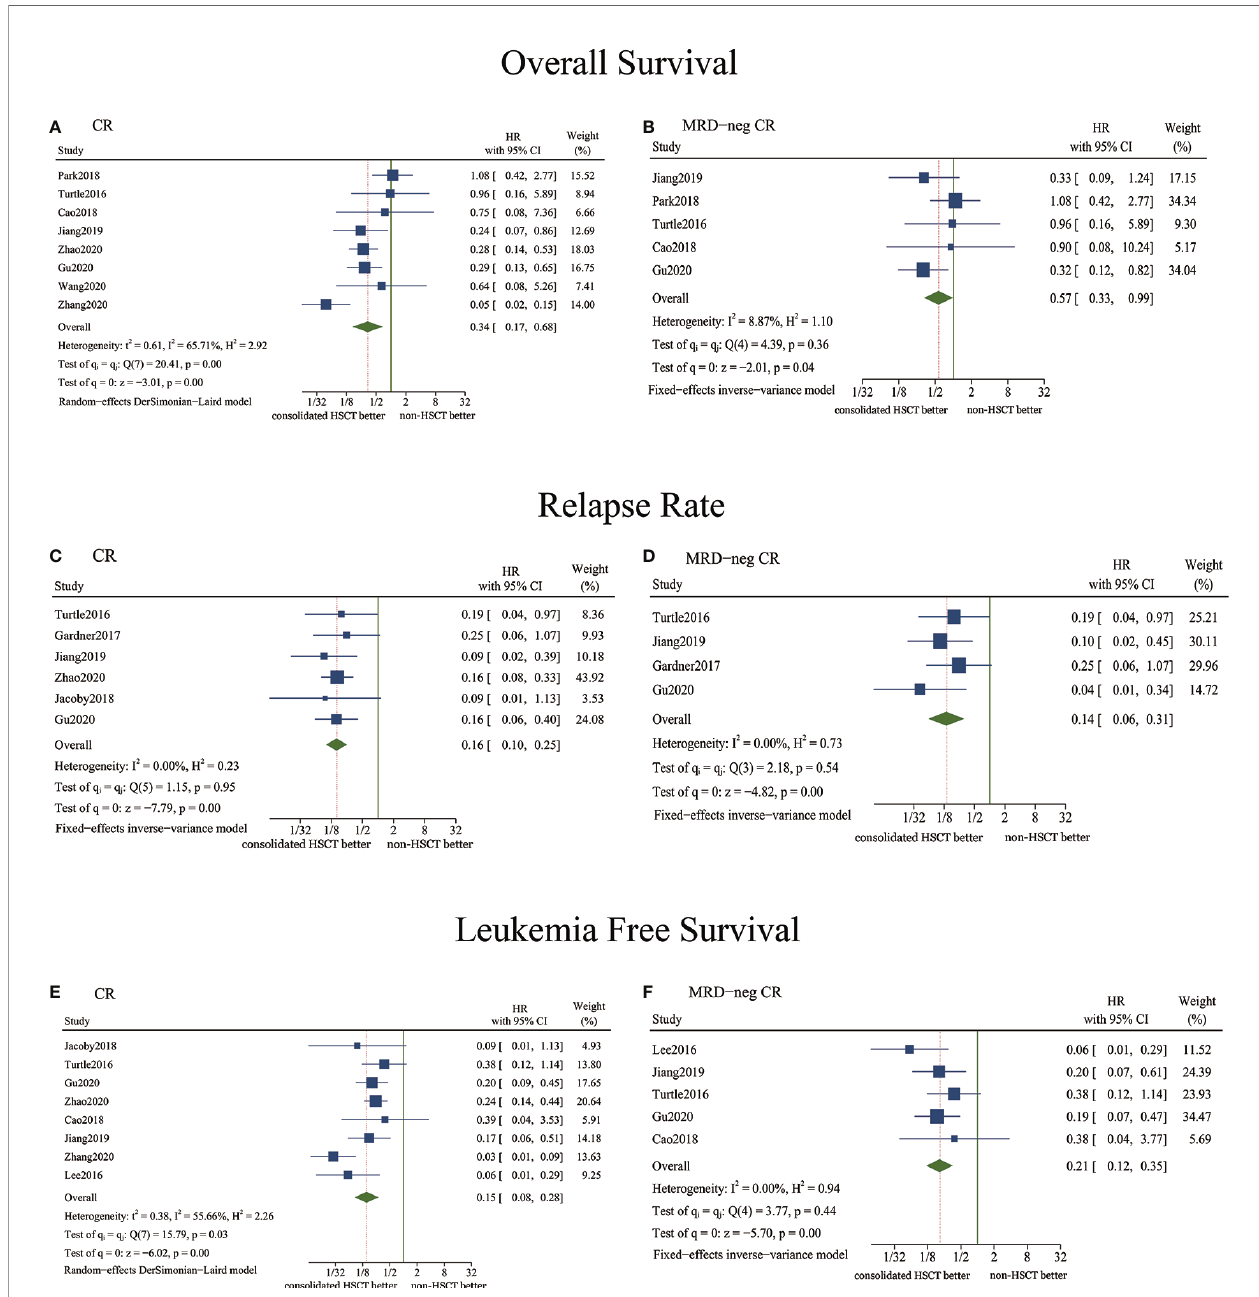
FIGURE 2 | Forest plots of ef fi cacy outcomes comparing consolidative HSCT and non-HSCT using pooled hazard ratios (HRs). (A) Overall survival (OS) analysis for patients achieving CR after CAR-T therapy; (B) OS analysis for patients achieving MRD-neg CR after CAR-T therapy; (C) Relapse rate analysis for patients achieving CR after CAR-T therapy; (D) Relapse rate analysis for patients achieving MRD-neg CR after CAR-T therapy; (E) Leukemia-free survival (LFS) analysis for patients achieving CR after CAR-T therapy; (F) LFS analysis for patients achieving MRD-neg CR after CAR-T